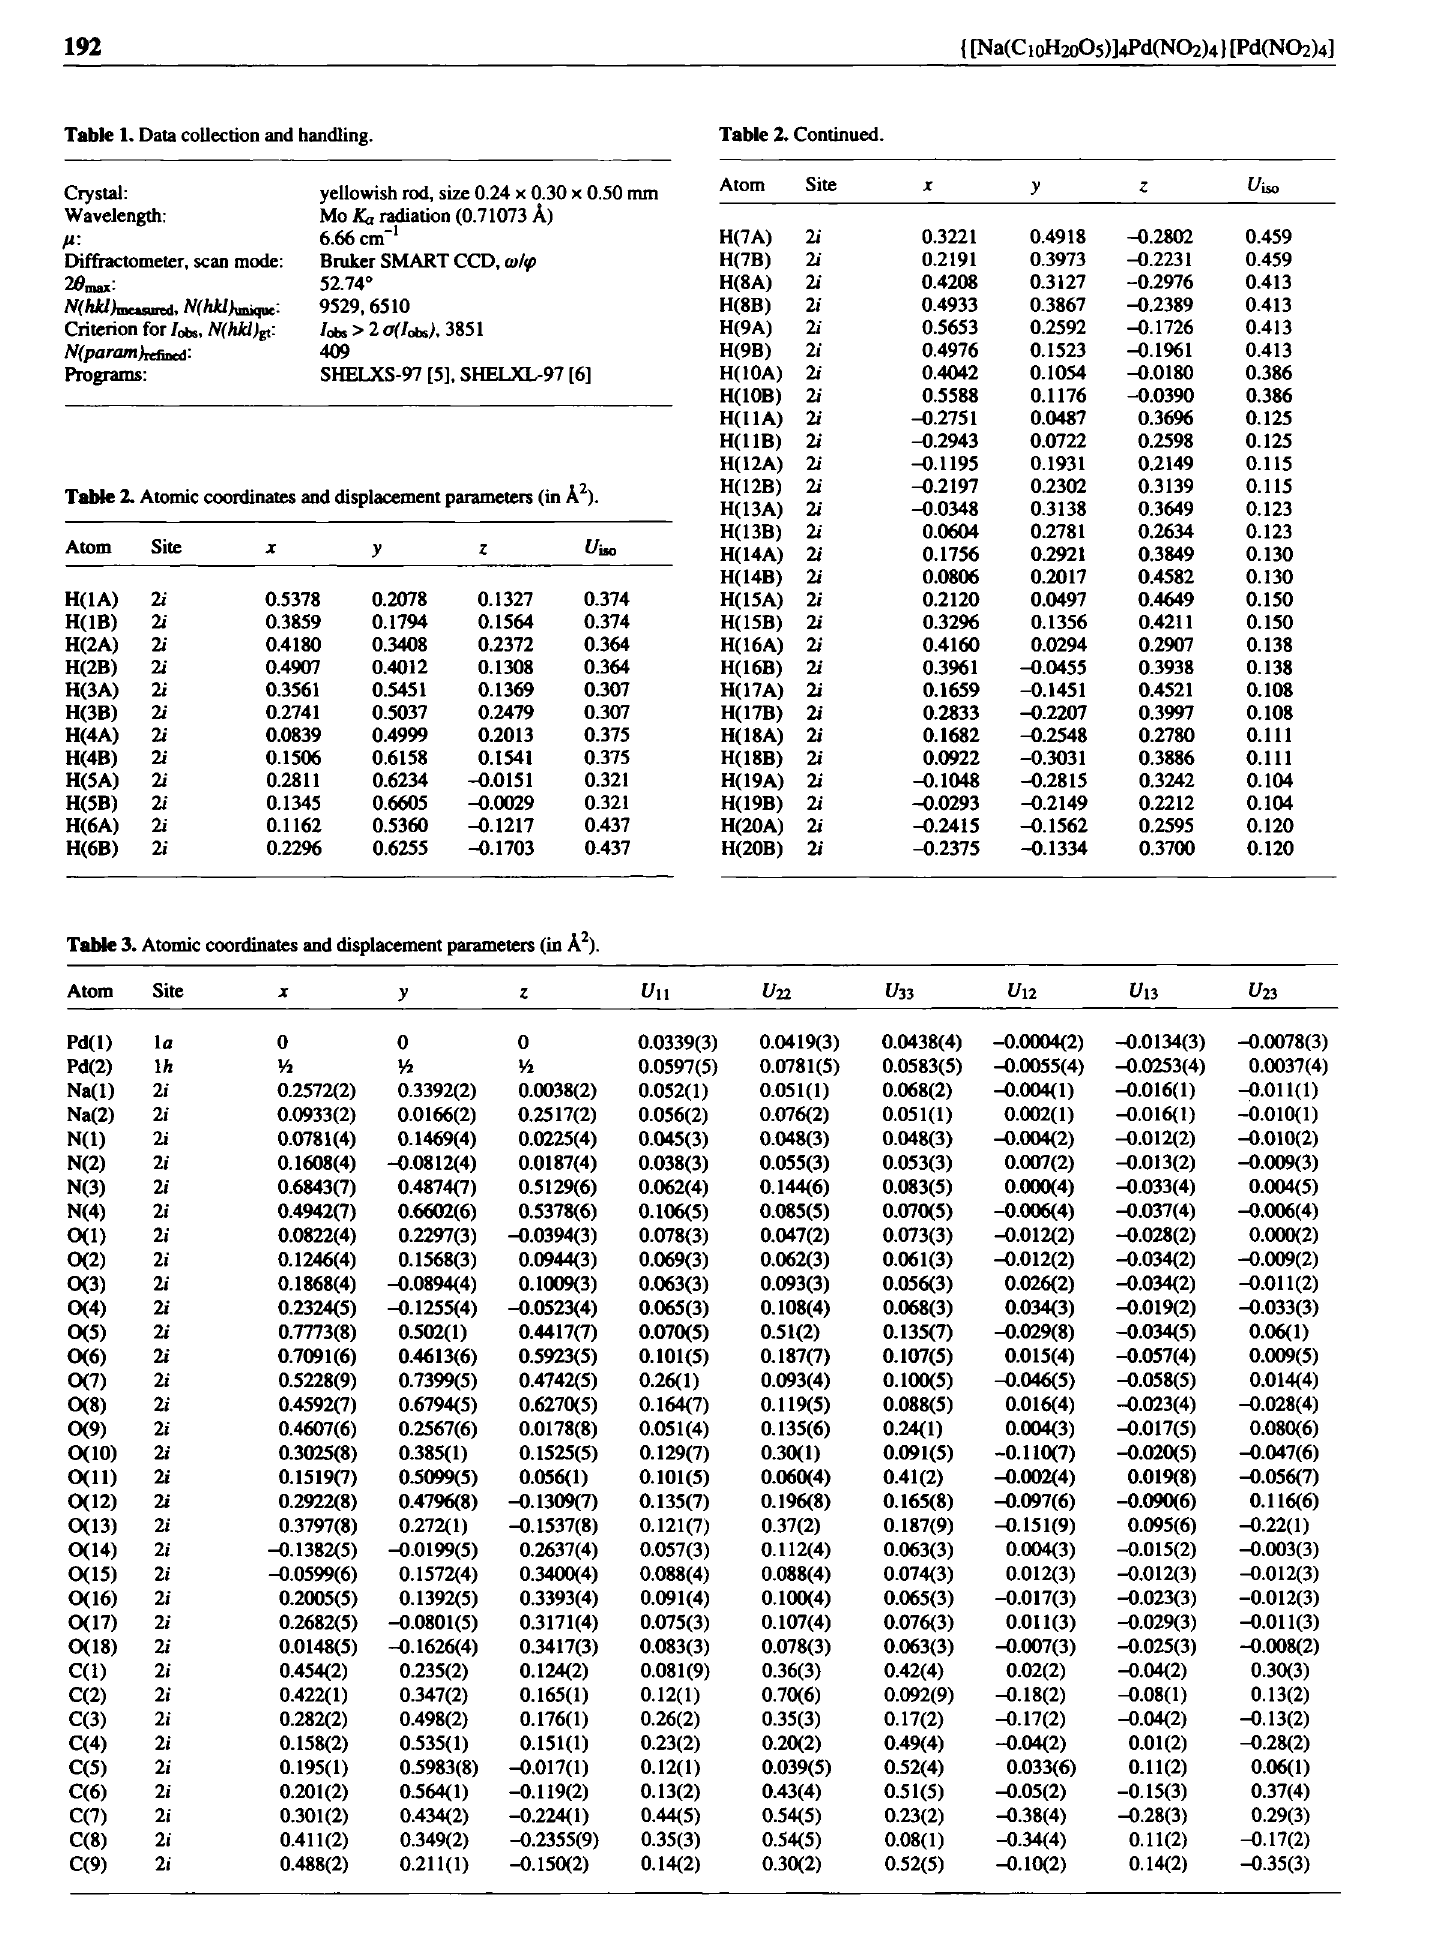
Table 1. Data collection and handling. Table 2. Continued.